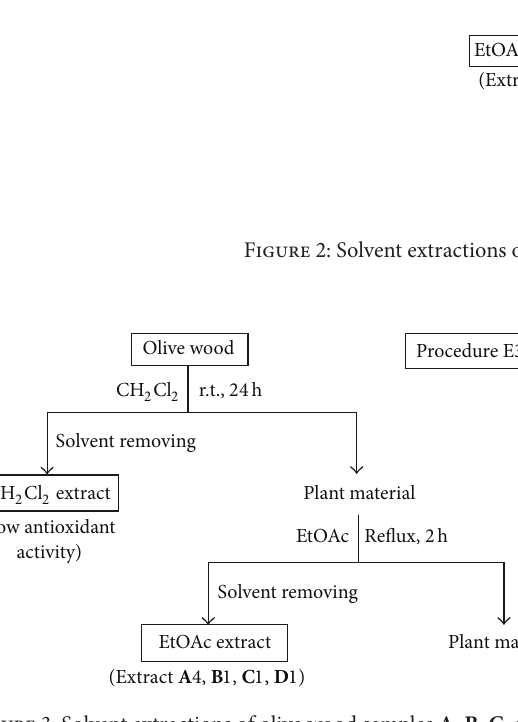
Figure 3: Solvent extractions of olive wood samples A , B , C , and D following procedure E3.